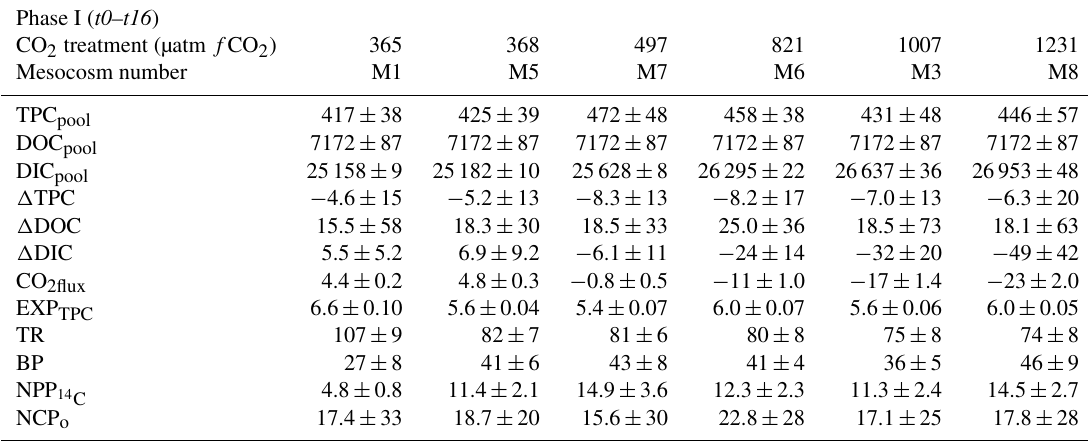
Table 1. The standing stock of total particulate carbon (TPC pool ), dissolved organic carbon (DOC pool ), and dissolved inorganic carbon (DIC pool ) at the start of phase I in mmolCm − 2 ± SE ( n = 2). The DOC pool was missing some initial measurements and is the average for all mesocosms assuming that the DOC concentration was similar at the onset of the experiment. The net changes in TPC ( (cid:49) TPC), DOC ( (cid:49) DOC), and DIC ( (cid:49) DIC) are average changes in the standing stocks during phase I in mmolCm − 2 day − 1 ± SE ( n = 8). Flux measurements of atmospheric gas exchange (CO 2flux ) and exported carbon (EXP TPC ) plus biological rates – total respiration (TR), bacterial production (BP), and net primary production (NPP 14 ) – and net community production estimated based on organic carbon pools’ (NCP o ) net primary C production are all averages for the whole of phase I in mmolCm − 2 day − 1 ± SE ( n = 13, 9, 16, 7, and 11 for CO 2flux , EXP TCP , TR, BP, and NPP 14 , respectively). SE for NCP o was calculated from the square root of the sum of variance of the three variables used in Eq. (6). C The NCP o was calculated from the net change in carbon pools plus carbon export, whereas NPP 14 was measured carbon fixation using C radio-labeled 14 C over a 24h incubation period in situ. TR was measured as O 2 consumption, and for comparison with carbon fixation we used a respiratory quotient (RQ) of 1. CO 2flux was only calculated for the period after full addition of CO 2 ( t4 – t16 ). A total budget of carbon fluxes for ambient and high CO 2 treatments is presented in Fig. 5.